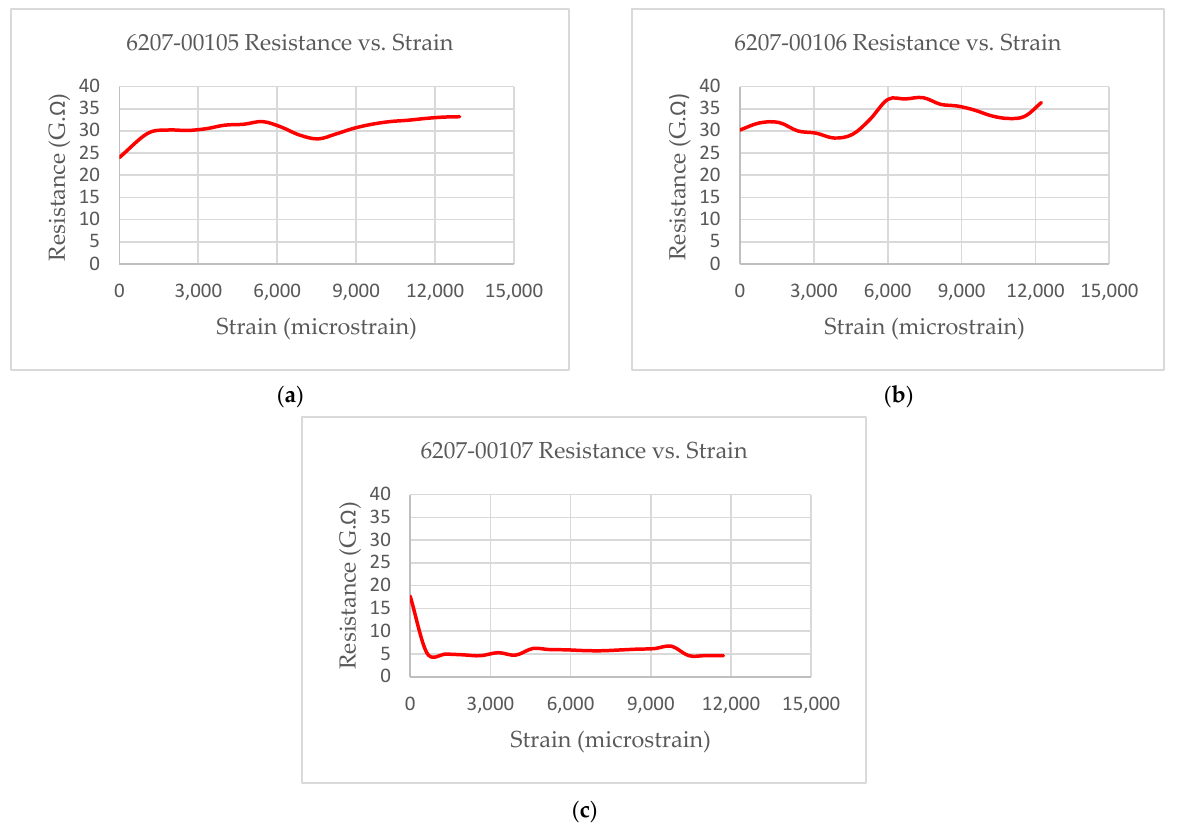
Figure 10. Multifunctional electro-tensile properties of specimens: ( a ) 6207-00105; ( b ) 6207-00106; ( c ) 6207-00107.